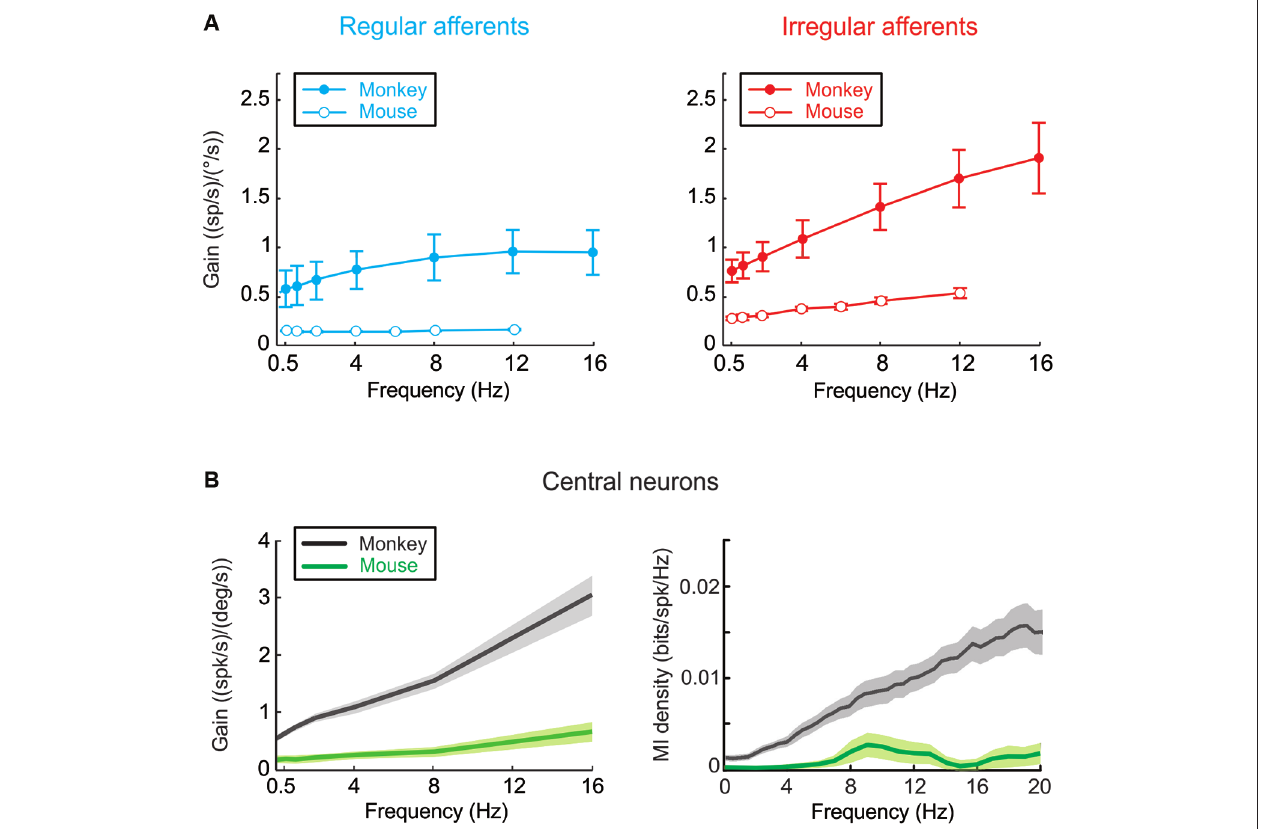
rotational sensitivities and mutual information density of mouse and monkey VN neurons. (Monkey data are adapted from Massot et al., 2011,